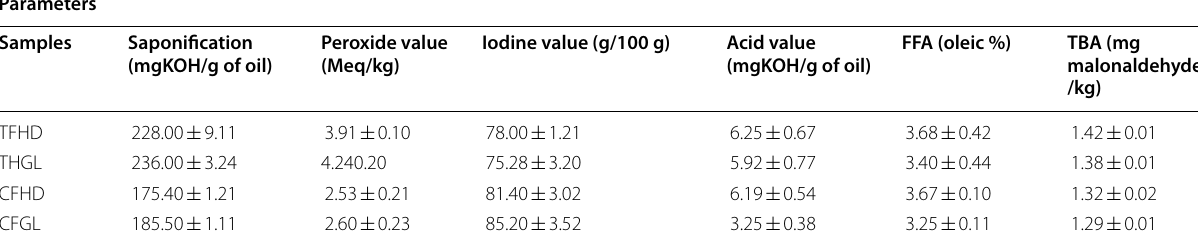
FFA free fatty acids; TBA =